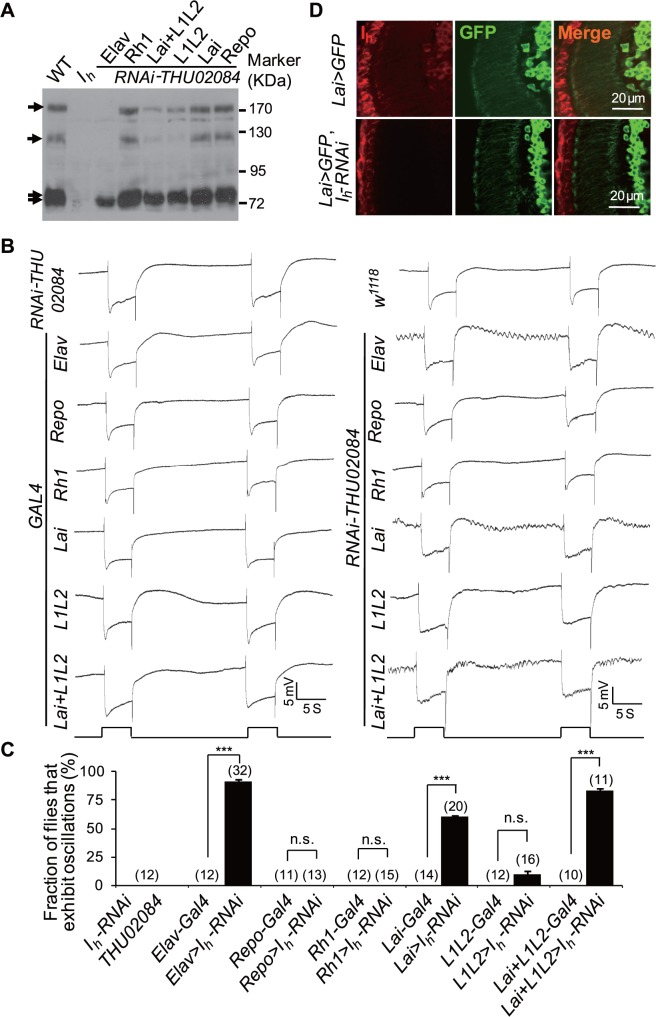
Depletion of Ih channels in ACs results in rhythmic depolarization in photoreceptors.(A) Ih channel expression levels in flies with Ih channel depletion using UAS-I
h-RNAi driven by anatomically restricted GAL4 drivers. A single copy of the GAL4 driver was used for each GAL4 line. Each lane was loaded with two fly heads. The Ih channel bands are indicated with arrows. (B) ERG traces of flies with Ih channels depletion using UAS-I
h-RNAi driven by anatomically restricted GAL4 drivers. A single copy of the GAL4 driver was used for each GAL4 line. (C) The fraction of flies that exhibit ERG oscillation phenotype in each genotype. The numbers of recorded flies for each genotype are listed. (D) Expression of Ih channels in UAS-mCD8-GFP,UAS-I
h-RNAi/Lai-Gal4 (bottom) and control (top) flies. Dissected whole brains were stained with anti-Ih (red) and anti-GFP (green) antibodies. Note that Ih channel distribution in UAS-mCD8-GFP,UAS-I
h-RNAi/Lai-Gal4 flies is comparable to control flies except in ACs.